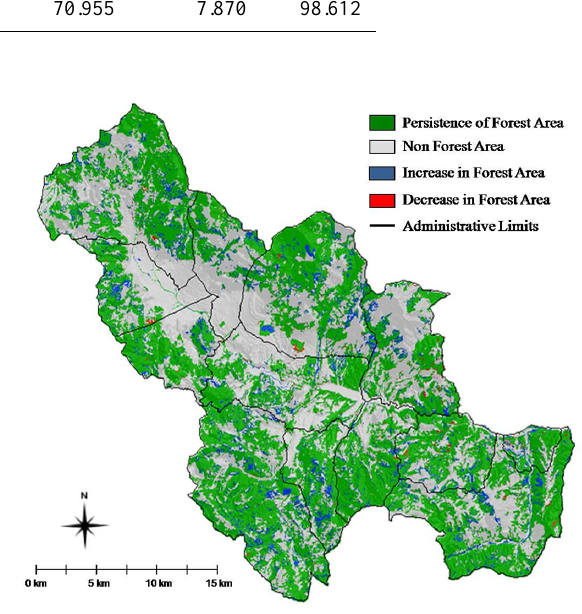
Figure 4. Forest area variation for the period